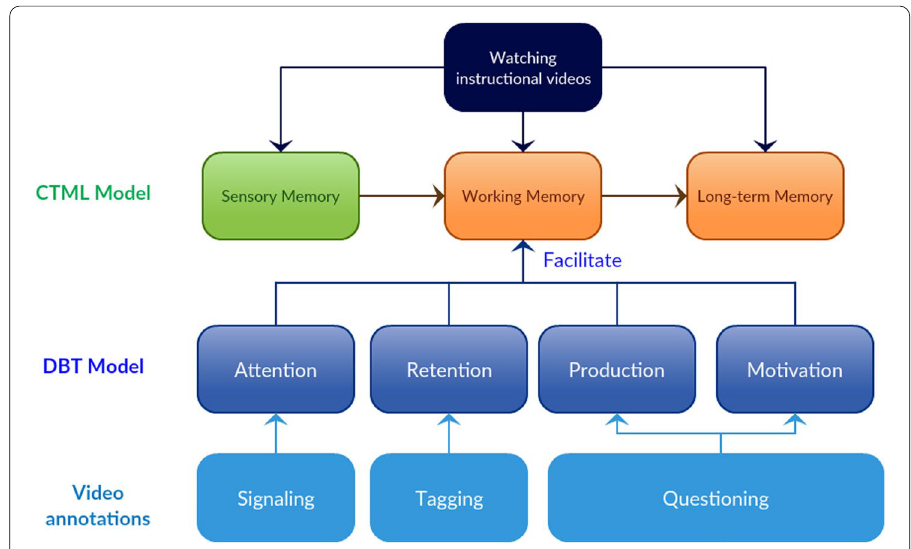
Fig. 2 DBT model of integrating video annotations into instructional